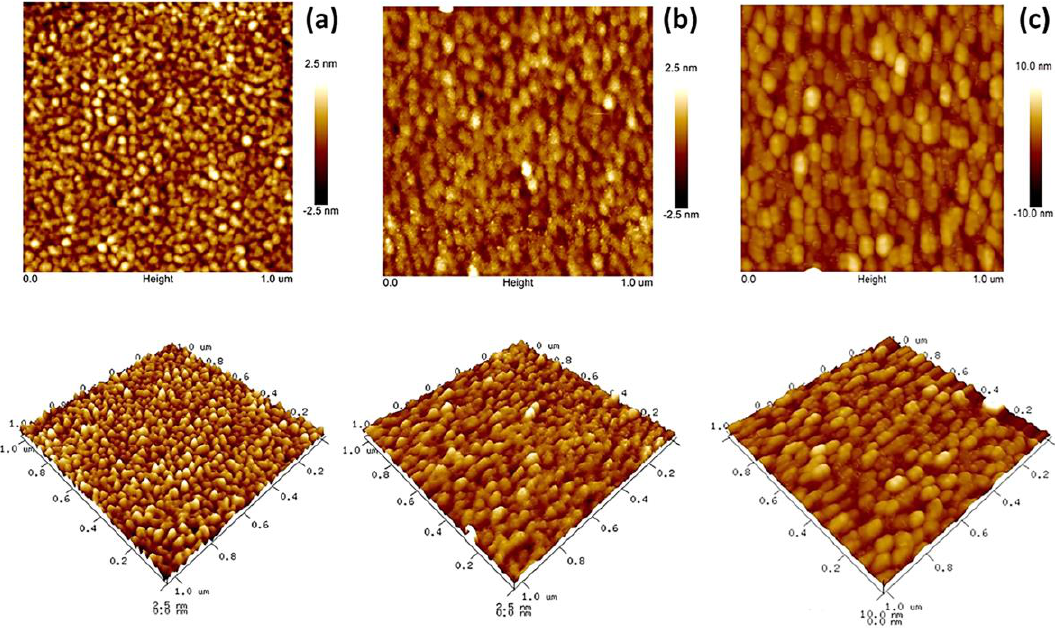
Figure 7. 2D and pseudo-3D AFM images of a bare gold electrode ( a ), after immobilisation of the aptamer ( b ), and after binding PCA3 to the aptamer ( c ).